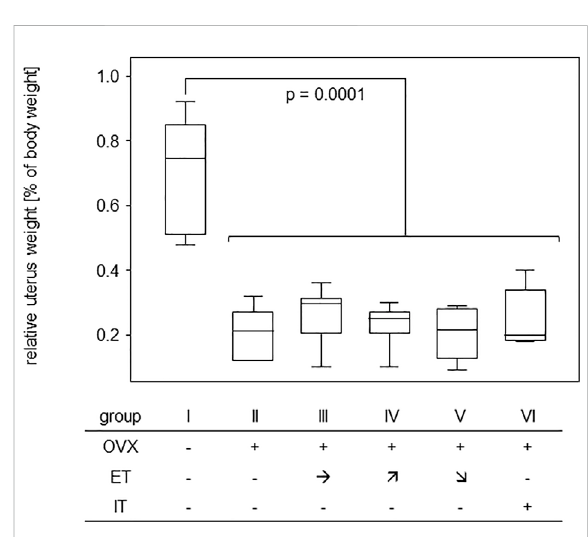
FIGURE 4 Effective OVX was con fi rmed by signi fi cant weight reduction of uteri. Box plots represent uterus weights compared to body weights for all groups. Statisticswere calculated by Mann-Whitney U-test and statistically signi fi cant difference is indicated by the p